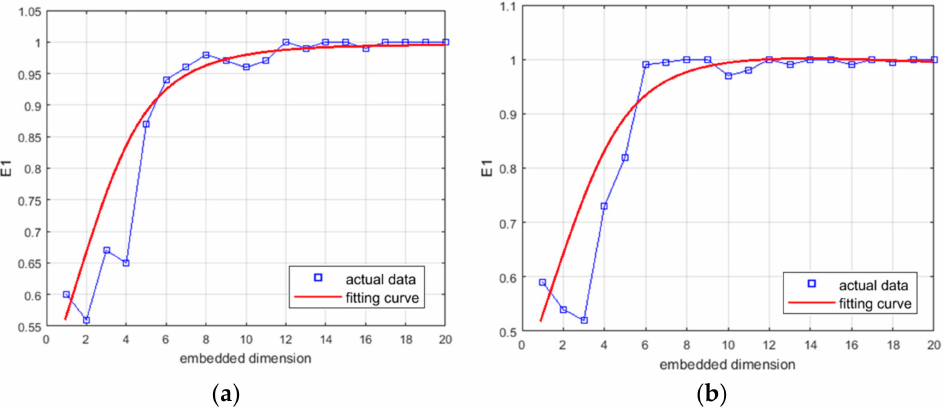
Figure 9. Embedded dimension. ( a ) Spatial domain. ( b ) Temporal domain.